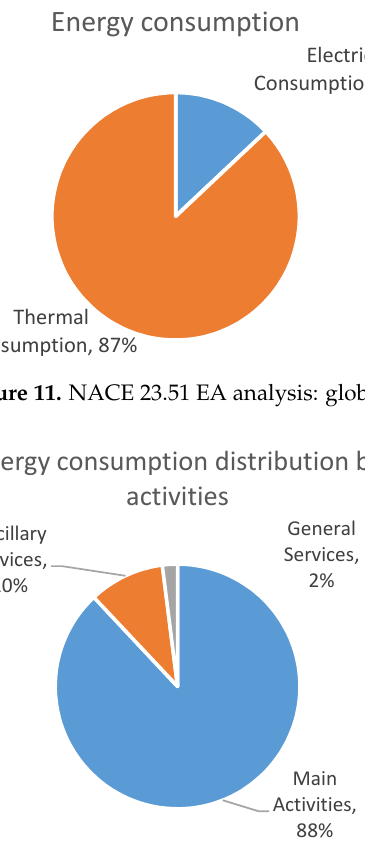
Figure 12. NACE 23.51 EA analysis: global consumption distribution by activity.